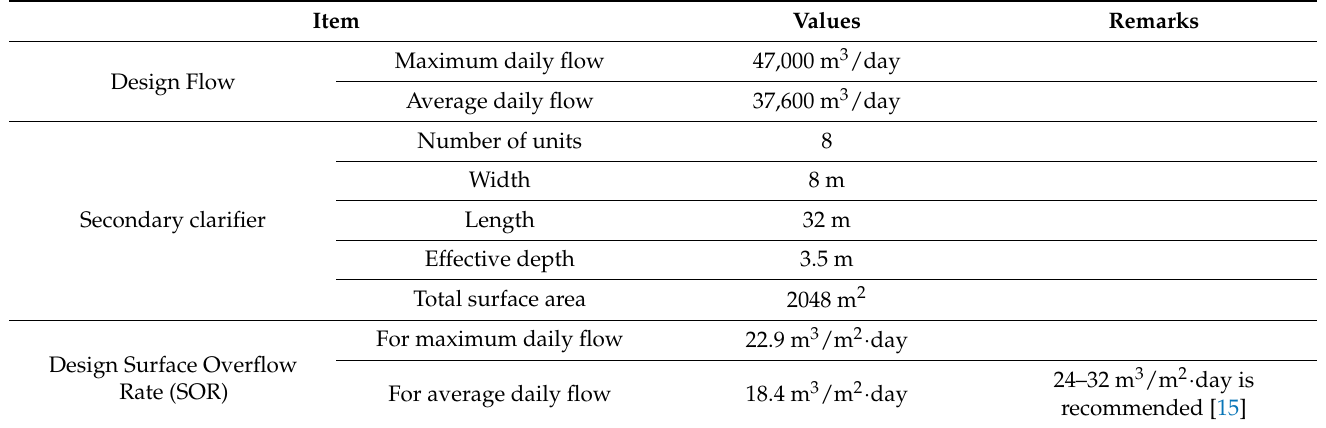
Table 1. Design specifications of the primary rectangular clarifier-type secondary clarifier at Plant